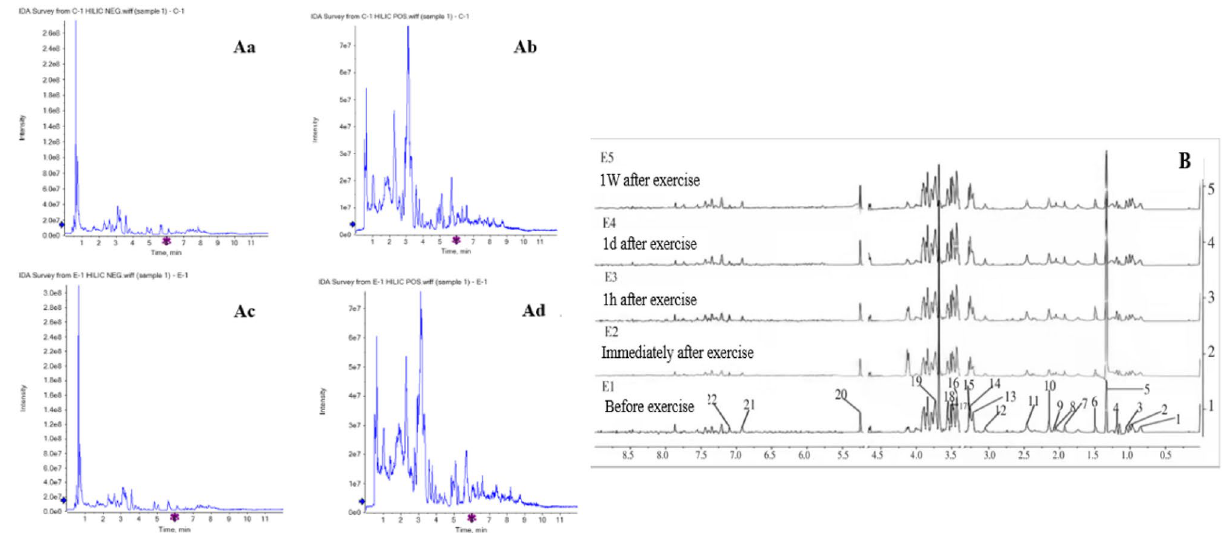
Figure 2. ( A ) The total ion current diagram of typical metabolites in a myocardial sample. ( a ) Group C negative ion current diagram, ( b ) Group C positive ion current diagram. ( c ) Group E negative ion current diagram.